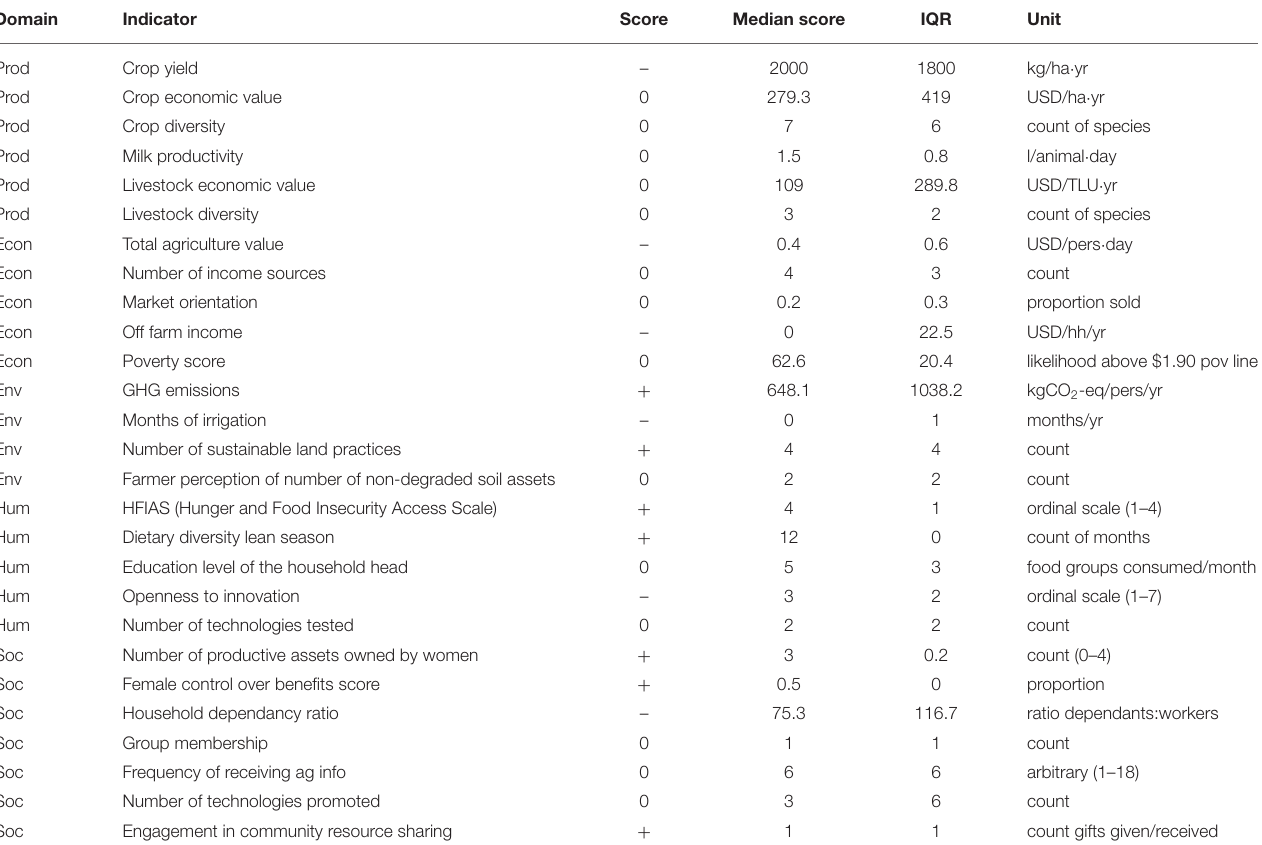
TABLE 2 | Scoring evaluation of the Sustainable Intensification Assessment Framework (SIAF), based on data collected in Ethiopia, 2018, of 800 farm households.